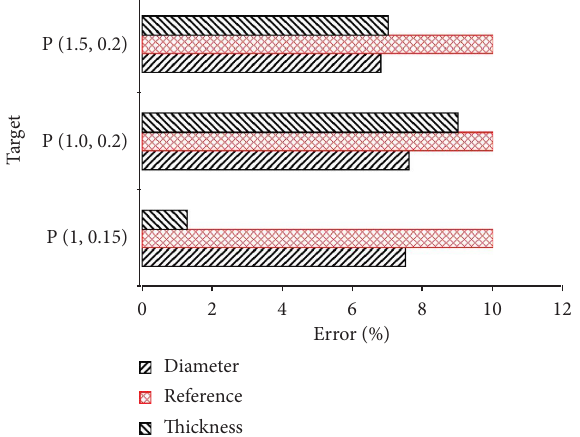
Figure 9: Error between experimental result and target dimensions compared with